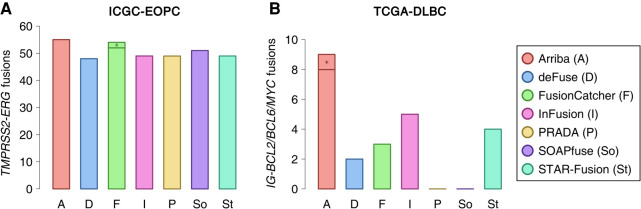
Recall of hallmark gene fusions in prostate cancer and diffuse large B-cell lymphoma. To measure the performance of Arriba and alternative methods on real patient data, we counted the number of hallmark gene fusions detected by each method in two cohorts. Fractions marked with an asterisk were only detected when a list of known/expected fusions was provided. (A) TMPRSS2-ERG fusions in the ICGC-EOPC cohort. (B) IG-BCL2/BCL6/MYC fusions in the TCGA-DLBC cohort.